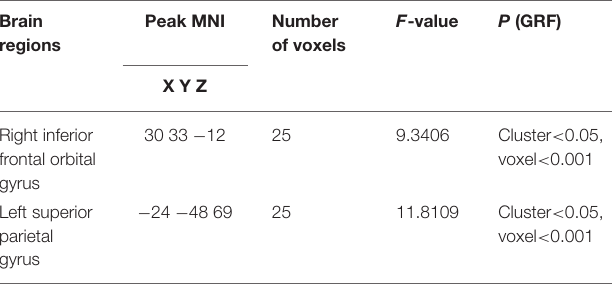
Frontiers in Psychiatry |